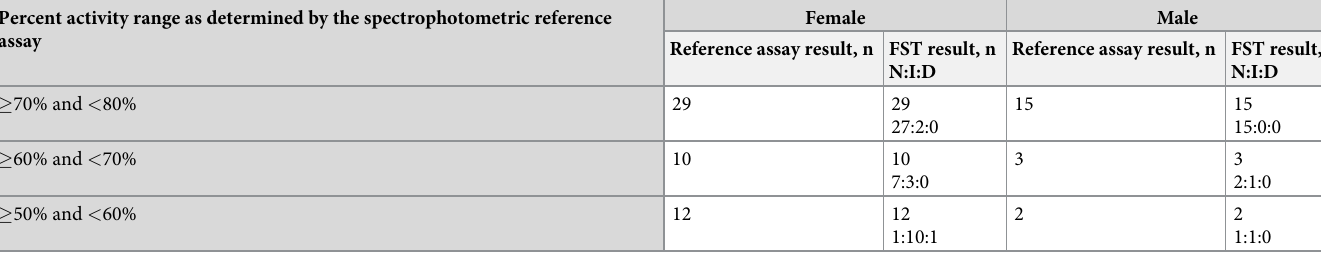
Table 3. Number of females and males within intermediate G6PD activity ranges (50 to 80%). The fluorescent spot test (FST) results that are available are also shown. The results are provided in terms of normal, intermediate, and deficient (N:I:D). Percent activity range as determined by the spectrophotometric reference